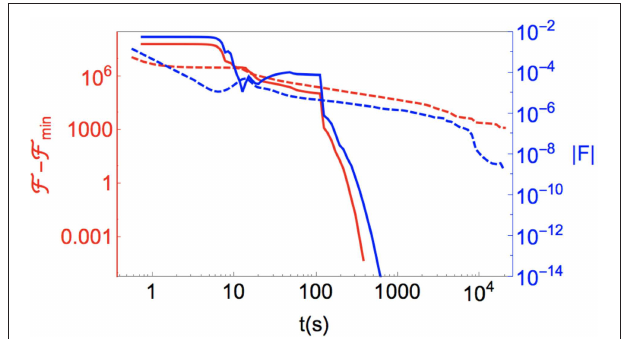
FIGURE 2 | (Red) Energy relative to the uniform texture with preferred nematic F min , and (blue) the norm of the residual force vector, order, F − F F / N , for bulk nematic (lattice size is N √ F | | = ∇ · ∇ randomly initialized configuration, as a function of wall-clock time. Solid lines are minimizations using FIRE and dashed lines are those using gradient descent. As described in the text, we have tuned the minimization parameters (step size, etc.) for each algorithm separately and use identical hardware to make a one-to-one